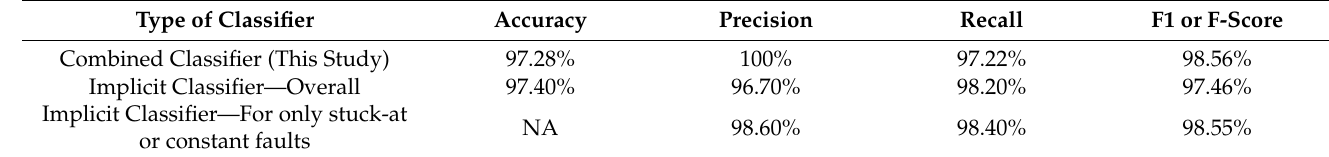
Table 29. Comparison of the evaluation results of combined classifier from this paper with implicit classifier in [31]. Type of